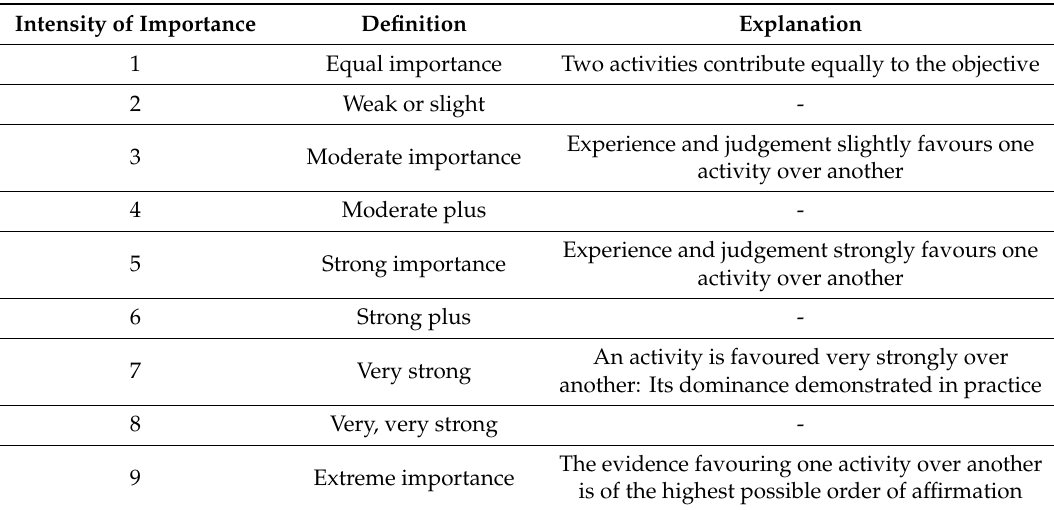
Table 4. Fundamental scale of absolute numbers